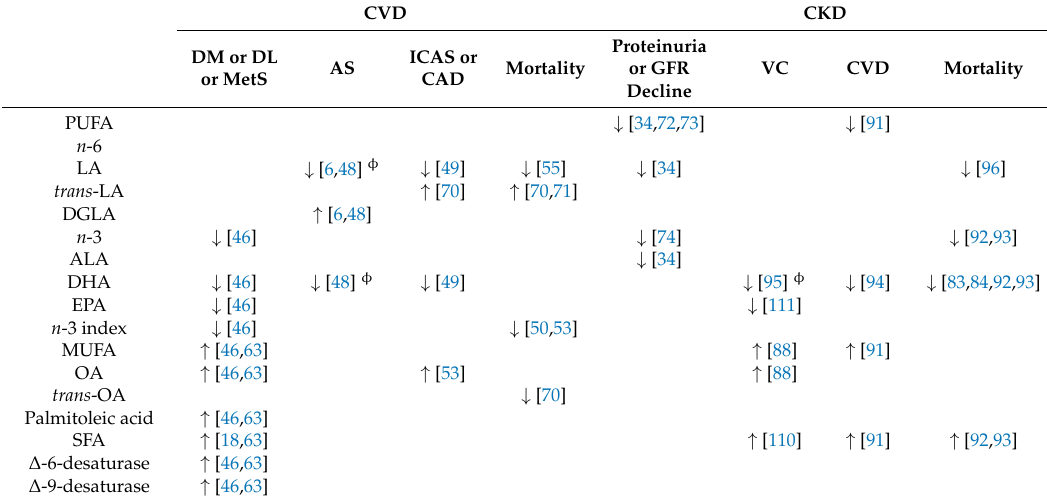
Table 2. Blood or erythrocyte FAs as predictors for risks of CVD and CKD.